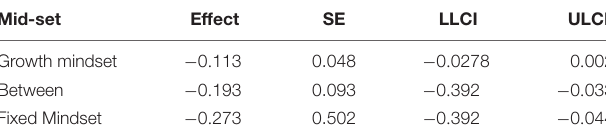
TABLE 4 | Conditional indirect effect (s) of X on Y at Values of the